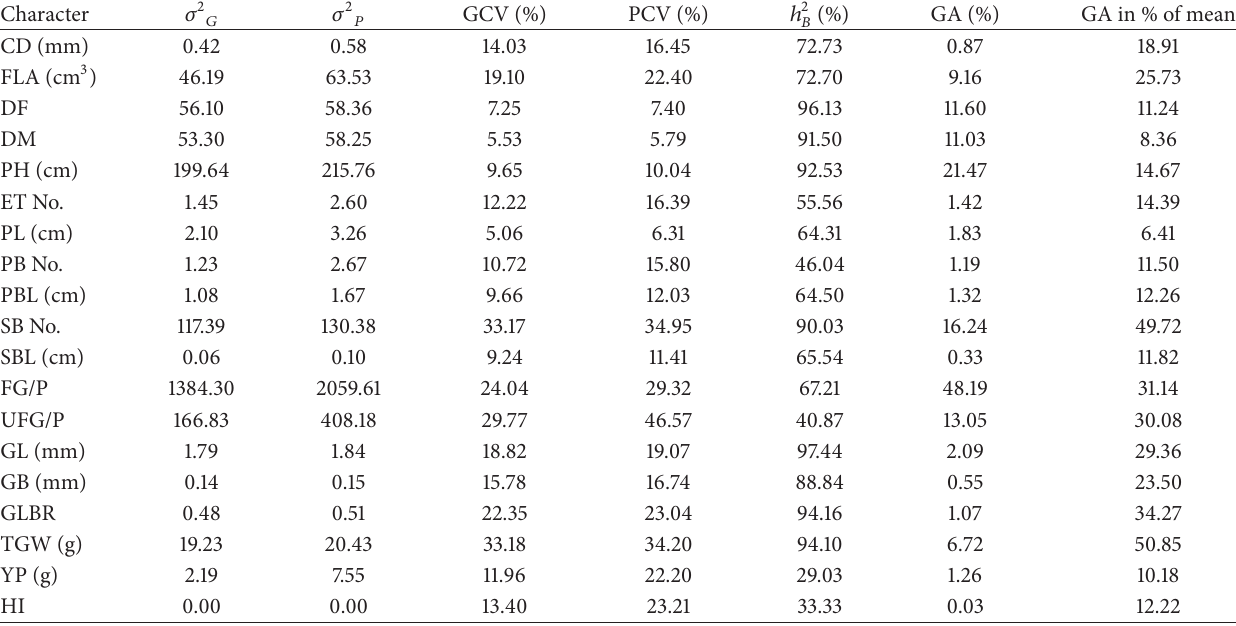
Table 5: Estimation of genetic parameters of different quantitative characters in 113 aromatic and fine rice